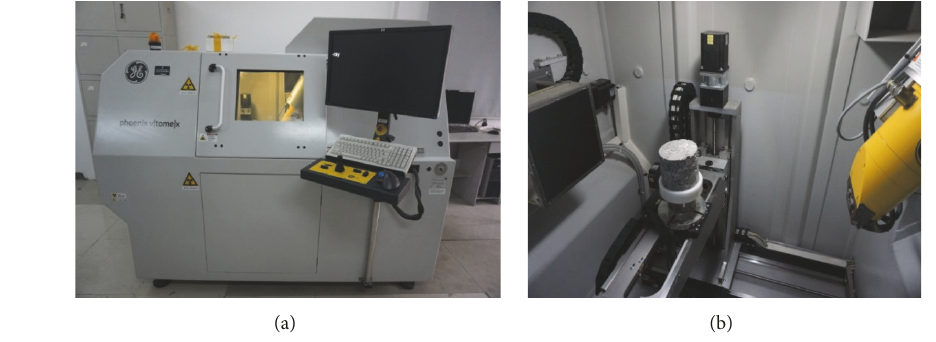
Figure 2: X-ray CT. (a) Exterior; (b) interior.